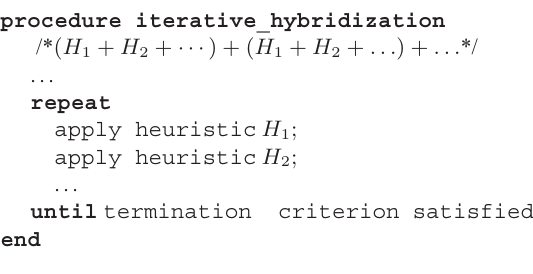
Figure 5. Pseudo-code for the framework of the iterative hybrid